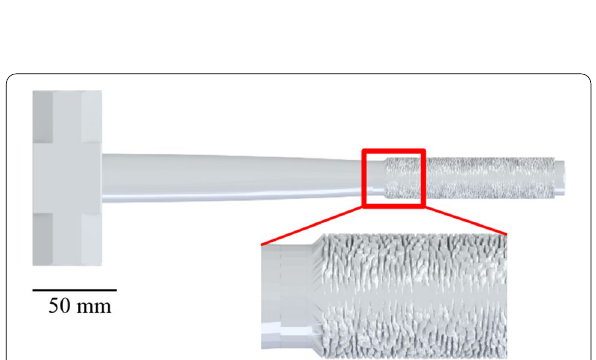
Figure 15 Sledgehammer with textured grip; distance preserving